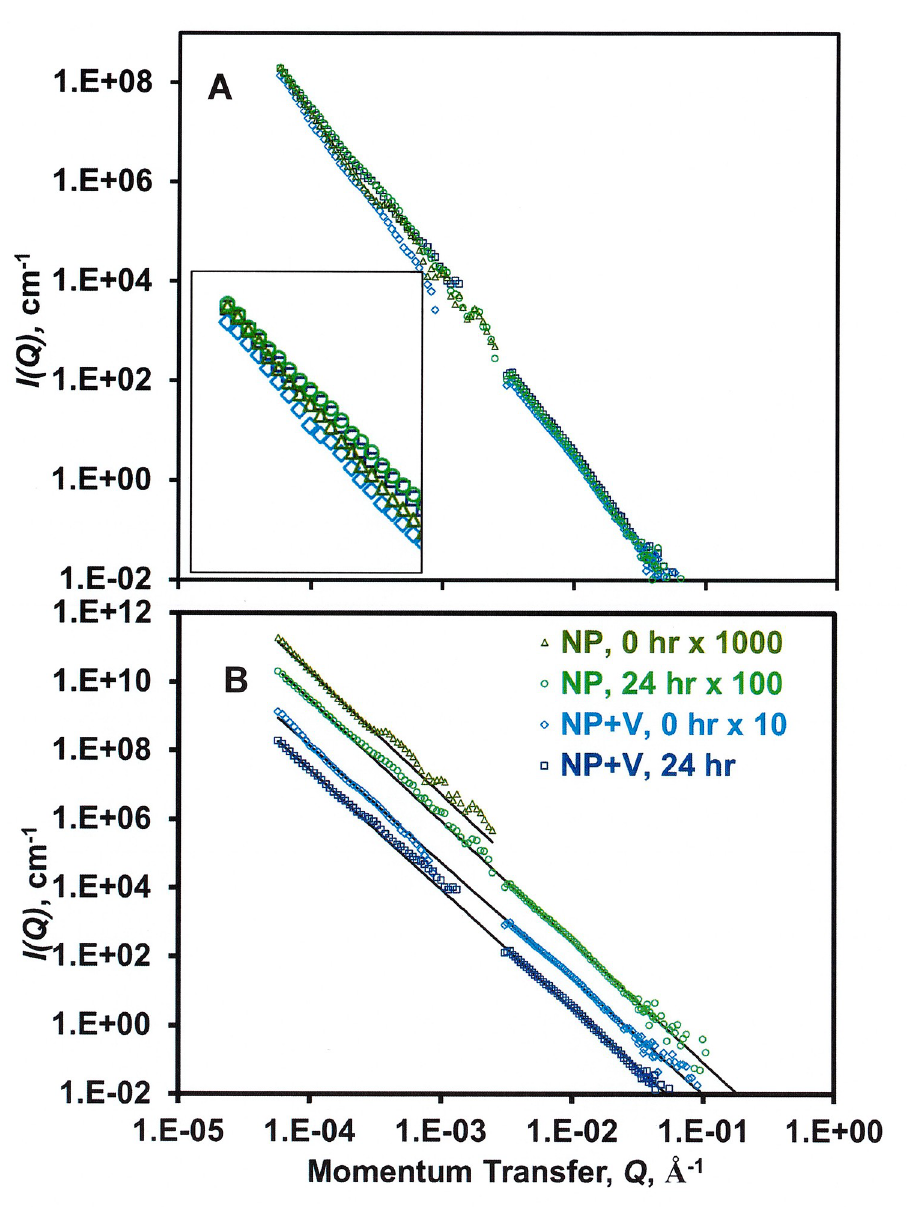
Fig 2. Effect of ex situ stirring and the presence vs. absence of vermiculite ( V ) on SANS data for NPs at the contrast match point for vermiculite (67% D 2 O in water; cf. Fig 1). NPs and V were present in the suspension at 1.0 wt% and 0.5 wt%, respectively. (A) SANS and USANS data (inset: an expansion of the data at low Q ) and (B) power law fitting (Eq 1) of data in Fig A [ I(Q) = α Q - β , where β = 3.4–3.6]. For Fig B, I(Q) was multiplied by a constant (as given in the legend) to improve visualization. Error bars are smaller than the size of the